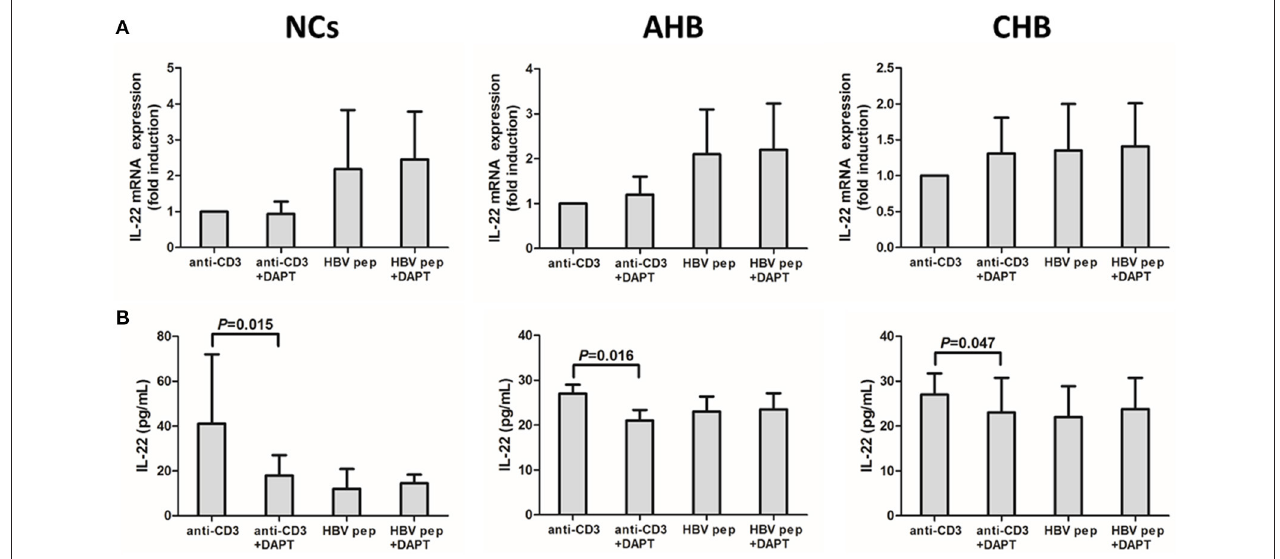
FIGURE 6 | Inhibition of Notch signaling did not affect IL-22 mRNA expression in isolated CD4 + T cells, but reduced the HBV non-specific IL-22 production in the supernatants from cultured CD4 + T cells. (A) mRNA expressions corresponding to IL-22 in CD4 + T cells were measured by PT-CPR. Results are displayed as fold differences relative to anti-CD3 treatment, and normalized to 18sRNA. (B) IL-22 production in the supernatants were measured by ELISA. All values are presented as the average from each group, and error bars represent